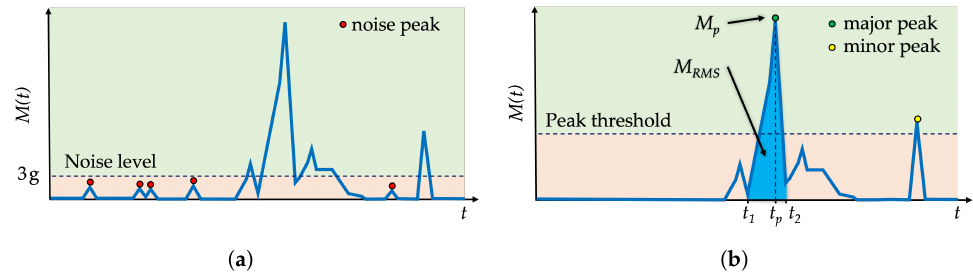
Figure 4. Example of acceleration magnitude values M ( t ) : before noise canceling ( a ); peak detection after noise canceling ( b